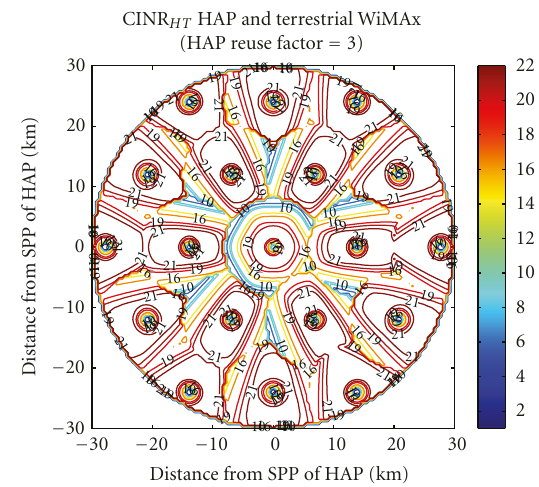
Figure 12: DL HAP system performance of user interfered by terrestrial deployments.